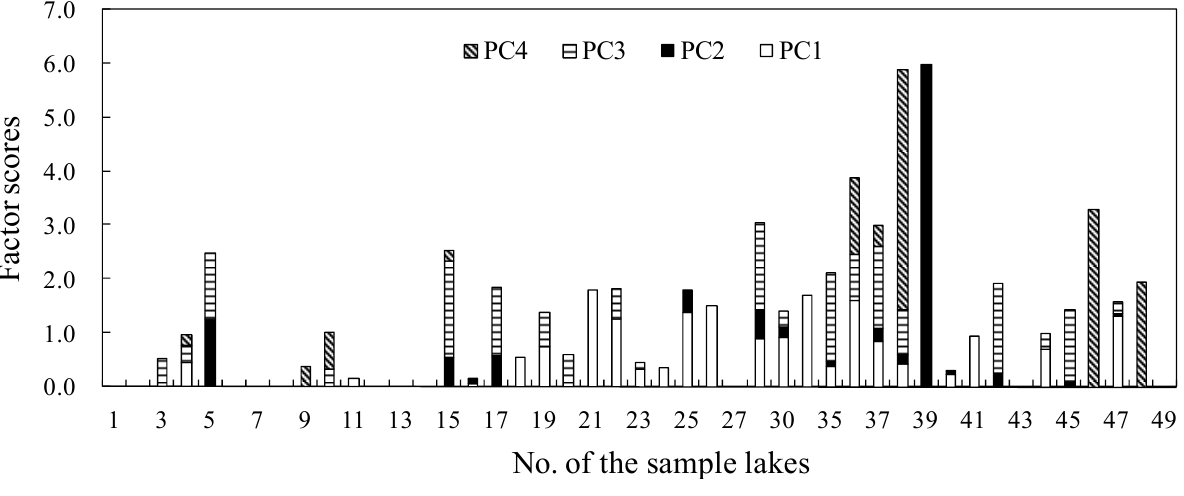
Figure 5. Spatial distribution of factor scores from PCA on the concentrations of elements (Negative scores not shown on the map). Lakes the Taihu Delta include No. 1 to No. 16; Lakes in the upper part of the lower Yangtze River include No. 17 to No. 39; Lakes in the the middle reach of the Yangtze River include No. 40 to No.